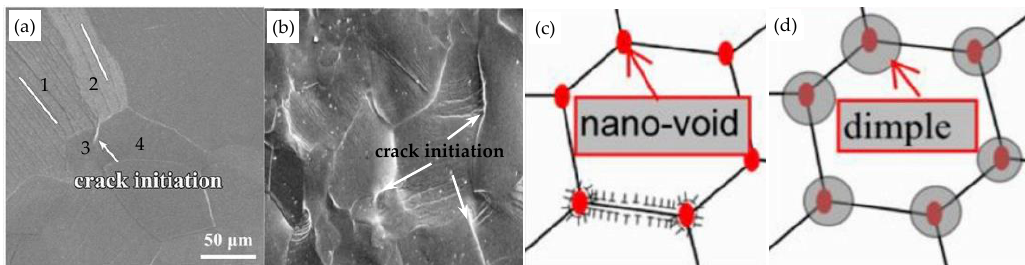
Figure 13. Crack initiation in intersection of α grain boundaries: ( a ) Ti-6Al [47]; ( b ) CP-Ti; ( c ) schematic of the nano-void nucleation; ( d ) schematic of the dimple nucleation [102]. The micro-cracks in lamellar structure tend to nucleate at the interface of intergranular α, and the deformability of intergranular α sheet is poorer than that of α lath colony